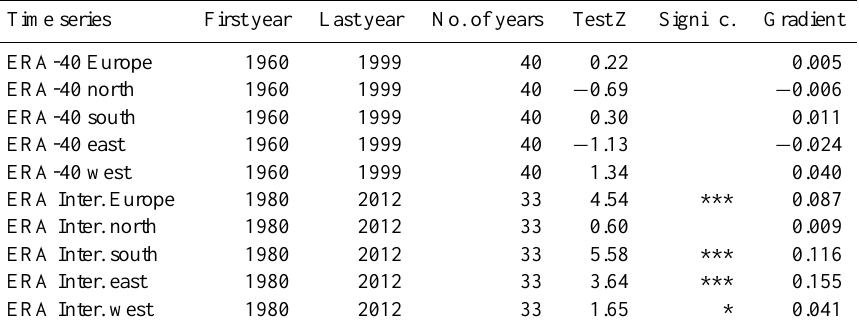
Table 1. Trend and gradient of the mean March–September FWI values as calculated for the regions of Europe in Fig. 1 using the modified Mann–Kendall test and Sen’s method on ERA-40 and ERA Interim data sets. The following symbols indicate significance at level α = 0.01 (***), α = 0.05 (**) and α = 0.1 (*). Last year No. of years Test Z